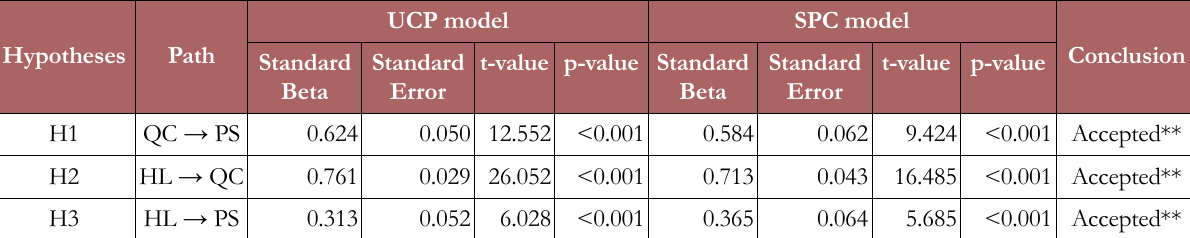
Table 8. Bootstrapping results for hypotheses